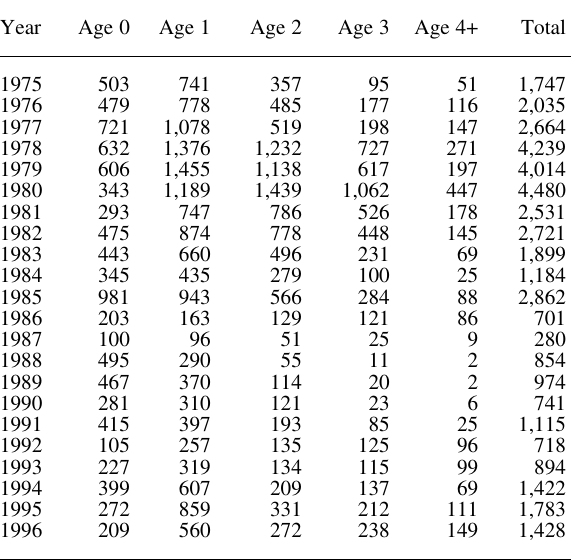
are reported in Table 6: the age classes refer to years and range from 0 to 4+, with the last class including individuals older than